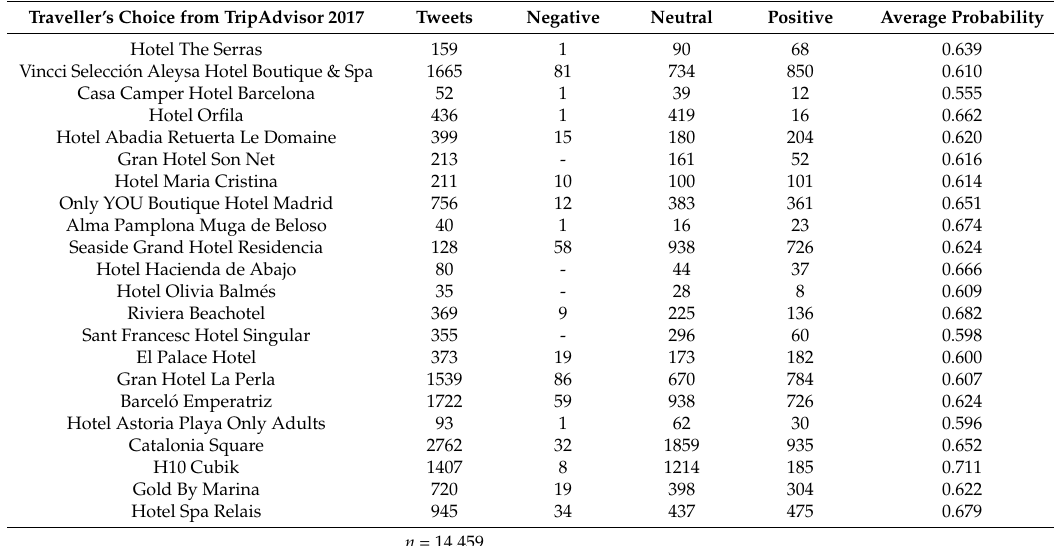
Table 7. Environment data which was analyzed and average classification probability percentages for each Hotel.